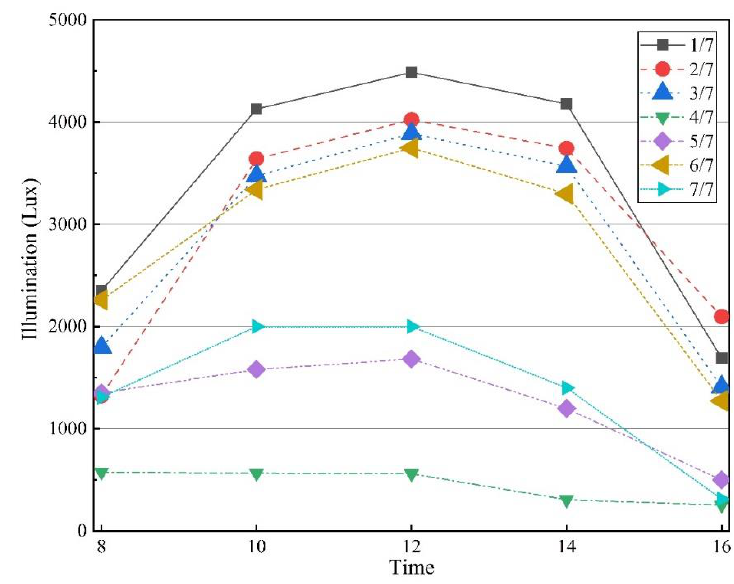
Figure 10. Mean of illumination of different depth position of B2 station.